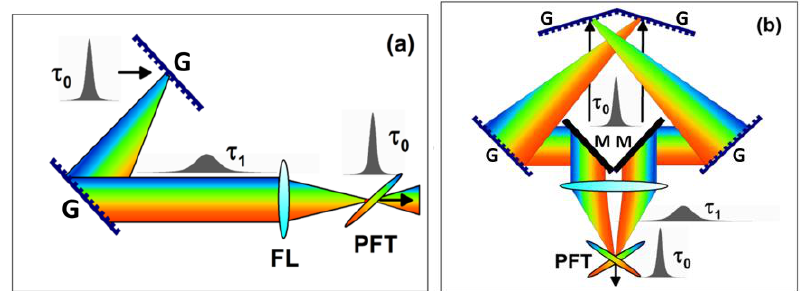
Fig. 1. Configurations for spatio-temporal focusing: (a) double-grating setup with asymmetric focusing, (b) 4-grating setup with symmetric focusing (PFT = pulse-front tilt, G = grating, FL = ocusing lens,  ,  = pulse durations with and without compression, M = mirror, schematically). 0 1